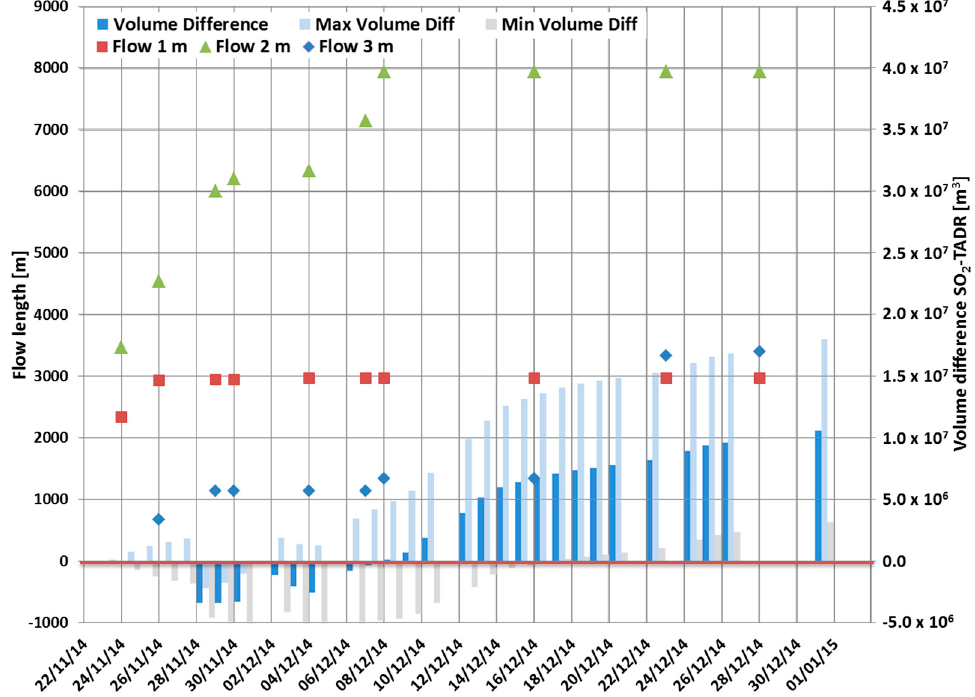
Figure 6. Graph showing maximum lava flow lengths (in meters) vs. time (dd/mm/yyyy) for the three arterial lava flows that developed during the Fogo 2014–2015 effusive eruption, Flow 1, Flow 2, and Flow 3. Note that Flow 1 increased its length only until the end of November; Flow 2 had two major growing phases, at the end of November and in early December; Flow 3 was mainly active during the second half of December, when the other two flows had largely halted. The difference in volume between the TADR measured by satellite and the Supply Rate calculated based on the SO 2 flux measurements (blue bar), with uncertainty bars (gray and pale blue bars), is also shown, with values increasing especially from early December onwards.